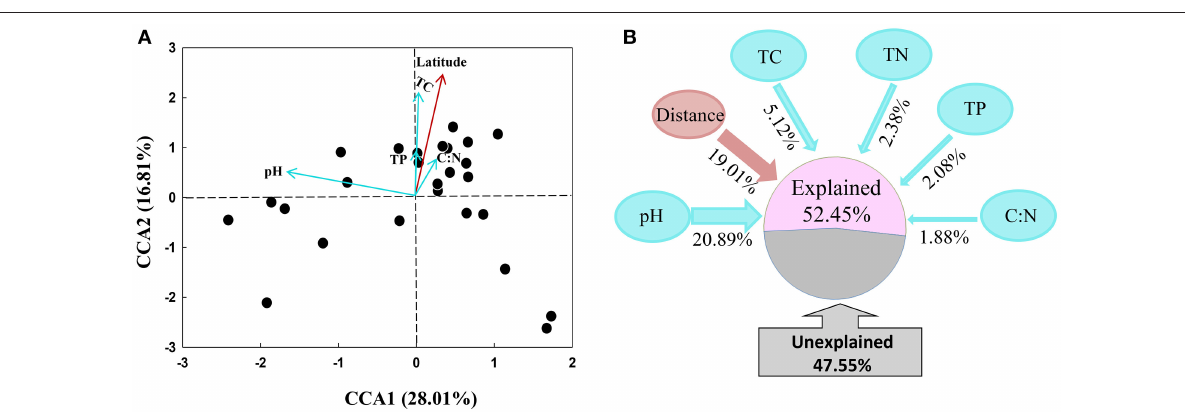
FIGURE 4 | Canonical correspondence analysis (CCA) of archaeal communities and environmental factors (A) , and variation partition analysis of spatial distance and soil variables on the explanation of variations of archaeal community structures (B) . multiple soil factors controlling the population of archaea in the black